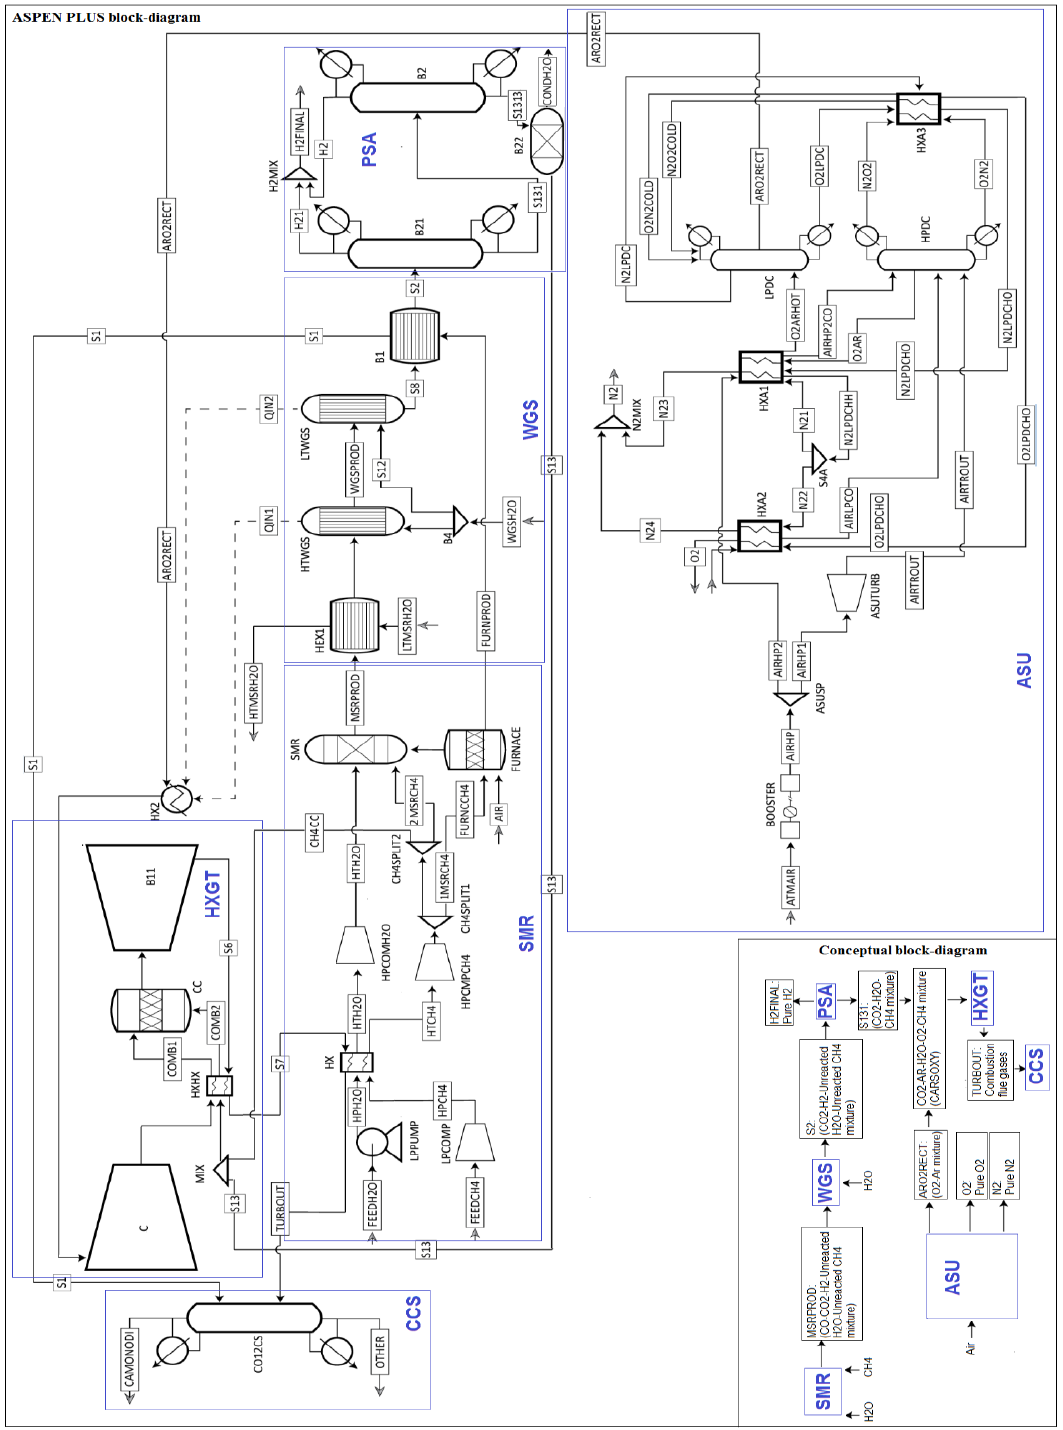
Figure 1. ASU-SMR-WGS-PSA-CCS-HXGT model.